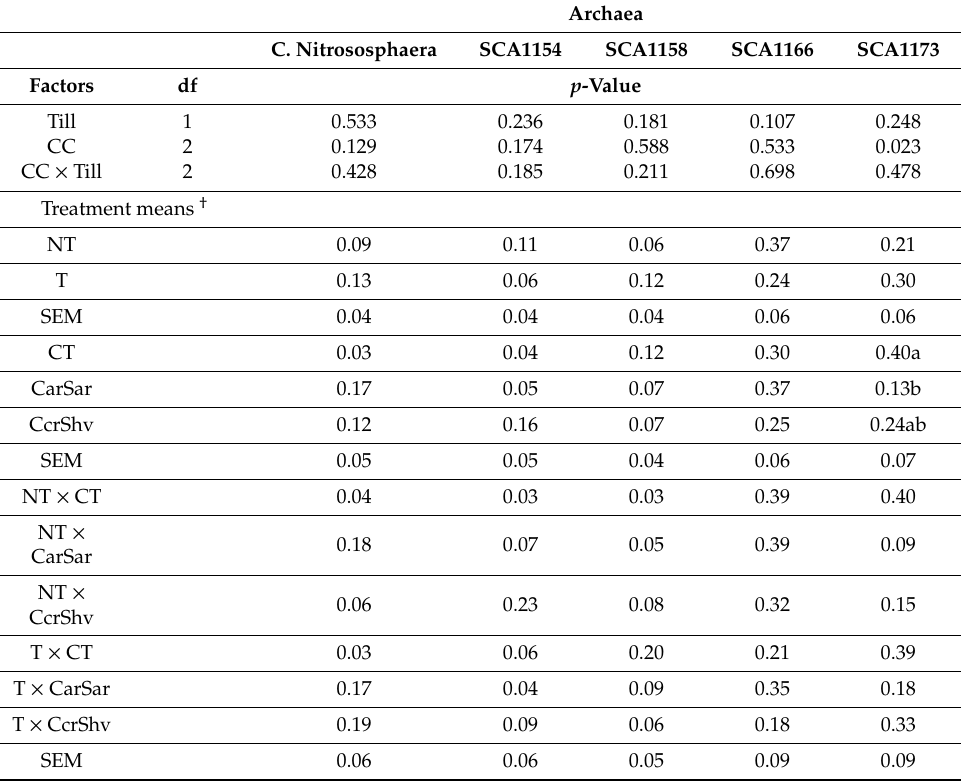
Table 5. Analysis of variance (ANOVA) results for the e ff ects of cover cropping (CC), tillage (Till), and their interaction (CC × Till) on the relative abundances (RAs, %) of archaeal indicator OTUs. The probability values of treatment e ff ects and the degrees of freedom (df) are shown on the top rows. The treatment mean values and their standard errors are presented below. Within a treatment, and for a given column, mean values followed by the same lowercase letter were not statistically di ff erent ( α =